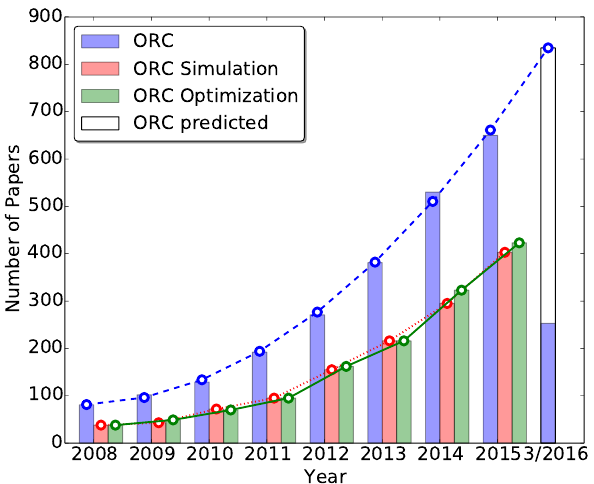
Figure 1. Survey of published papers on organic Rankine cycle (ORC) research by using three major keywords: “ORC”, “ORC simulation” and “ORC optimization” (updated to March